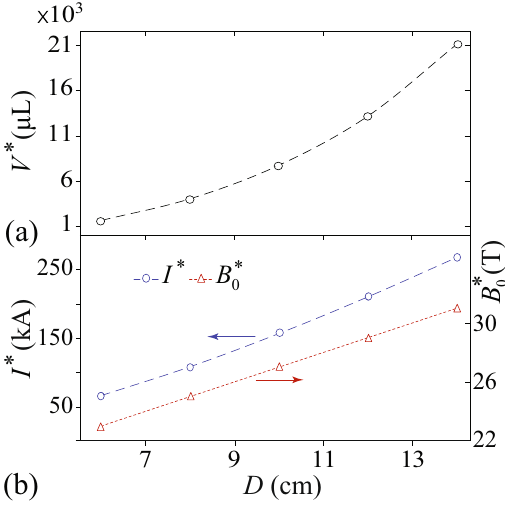
Fig. 4 Coil-size dependence of the optimal MLS parameters. a The maximum functional volume V * for coils with different diameters D . b The required optimum I * and B (cid:4) to achieve V * versus the coil 0 diameter D .